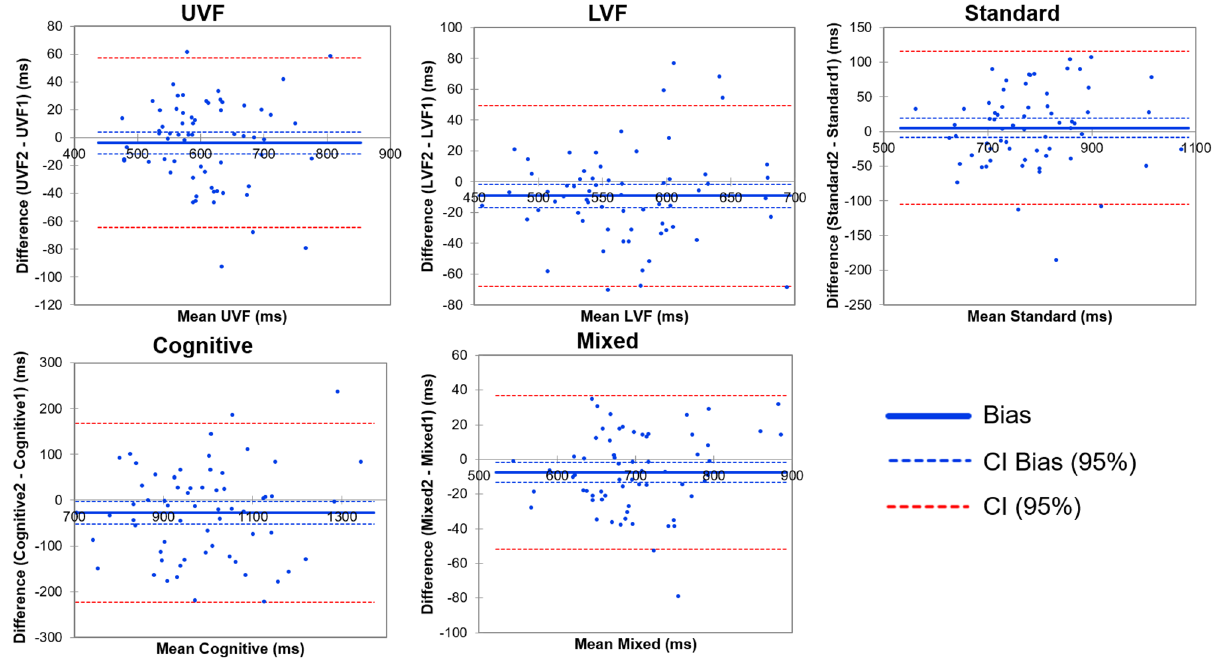
Figure 3. Bland Altman plots for test retest in each